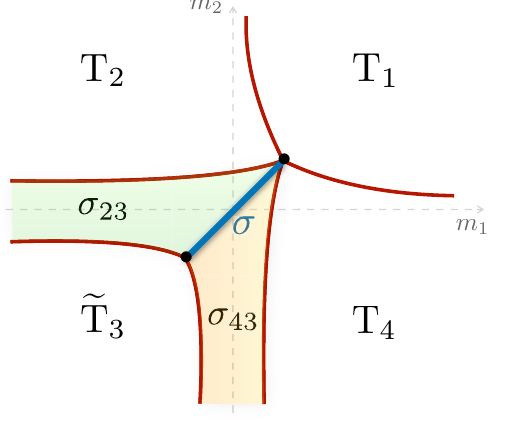
Figure 3 . Phase diagram of SU ( N ) k + p ψ 1 + ( F − p ) ψ 2 in the case k ≥ F/ 2.